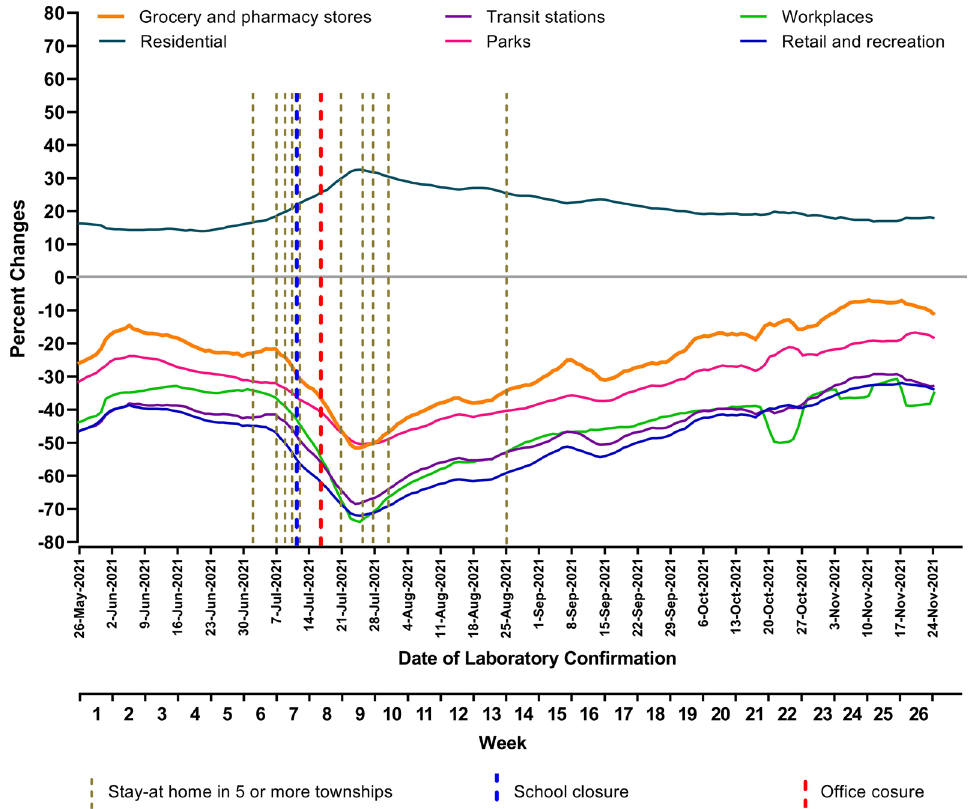
Fig. 3 Containment measures and community mobility trends in the third wave of the COVID-19 epidemic in Myanmar. Community mobility changes in the six categories were shown compared to baseline days of the median value for the 5-week period from January 3 to February 6 2020. The indexes were smoothed to the rolling 7-day average. Data source: https:// ourwo rldin data. org/ coron